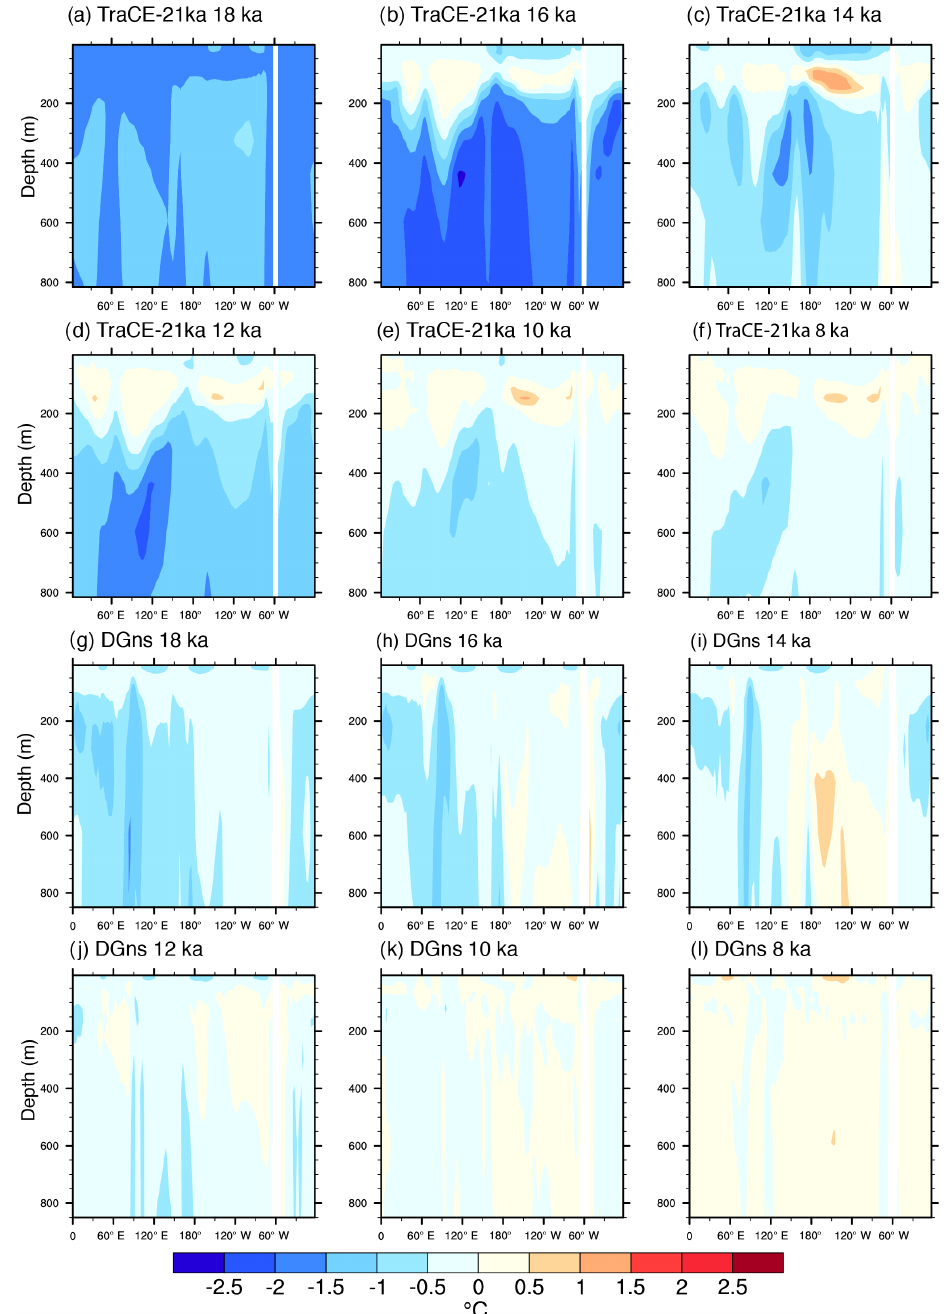
Figure 8. 2ka time slices of longitudinal cross sections of 100-year-averaged ocean temperature anomalies relative to PI at 64 ◦ S for the surface to 800m of depth: (a–f) TraCE-21ka 18 to 8ka; (g–l) DG ns 18 to